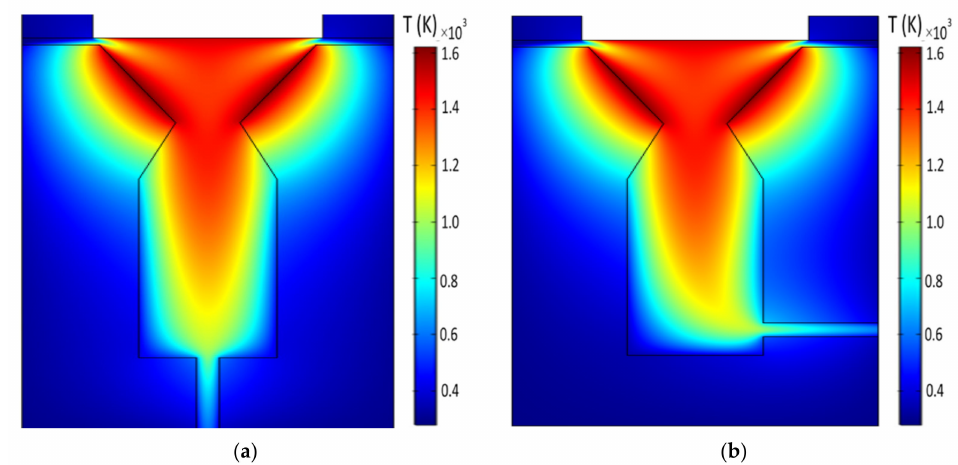
Figure 7. Temperature distribution along the axial length at 3.6 L / h flow rate and 150 kW / m 2 applied radiation flux on frustum edge: ( a ) bottom outlet geometry and ( b ) side outlet